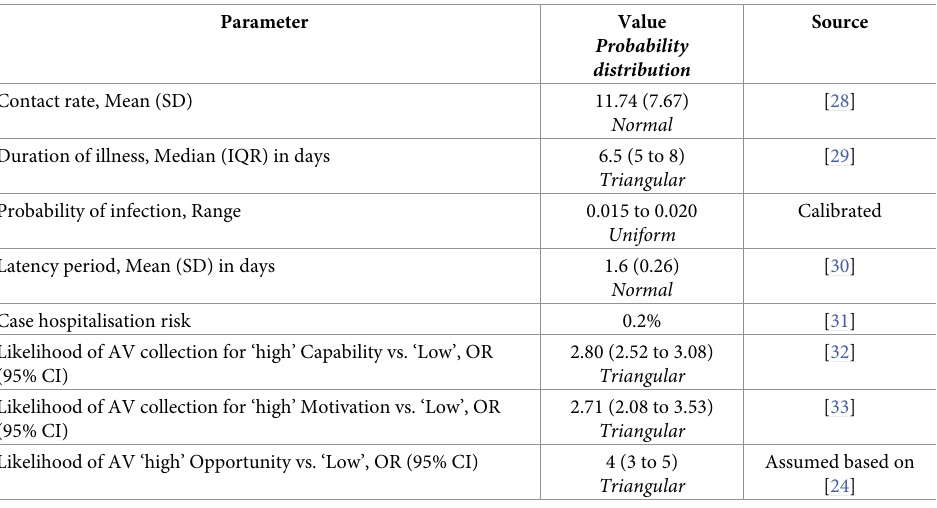
Table 2. Input parameters for the agent-based model. Parameter Value